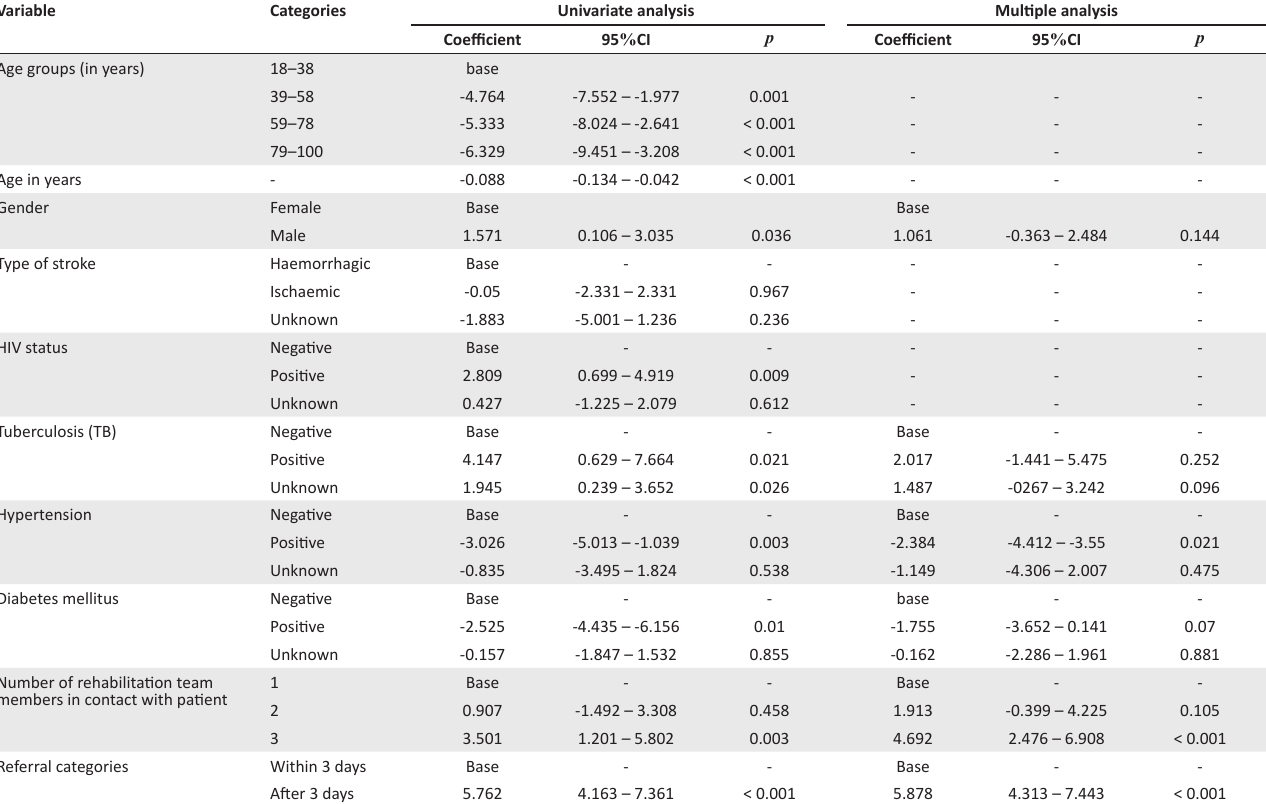
TABLE 2: To determine the factors contributing to length of hospital stay of participants using univariate and multiple linear regression.